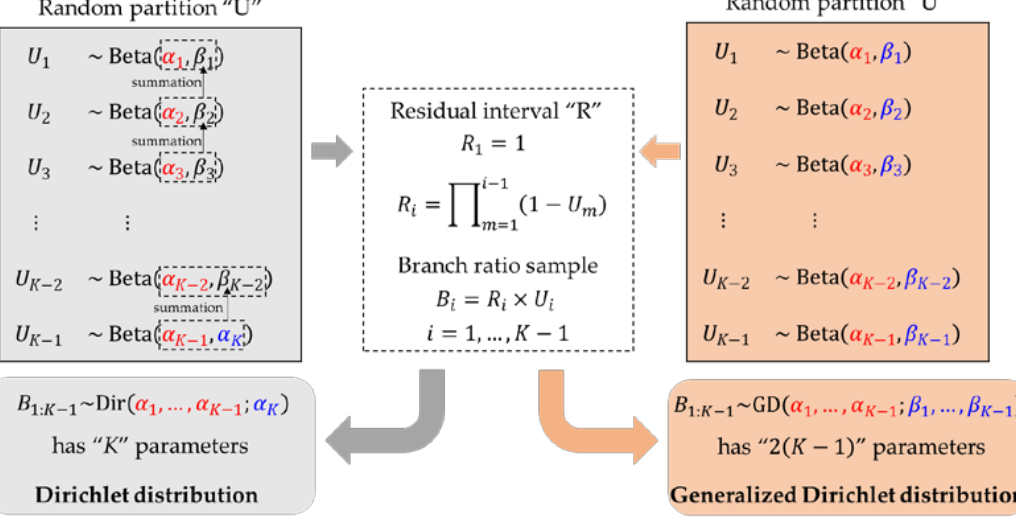
Figure 3. Relationship between Dirichlet and generalized Dirichlet distributions (Dirichlet distribu- tion and Generalized Dirichlet distribution shown in “grey” and “orange”, respectively. Branch ratios are calculated iteratively by the product of random partition “U” and residual interval “R”).